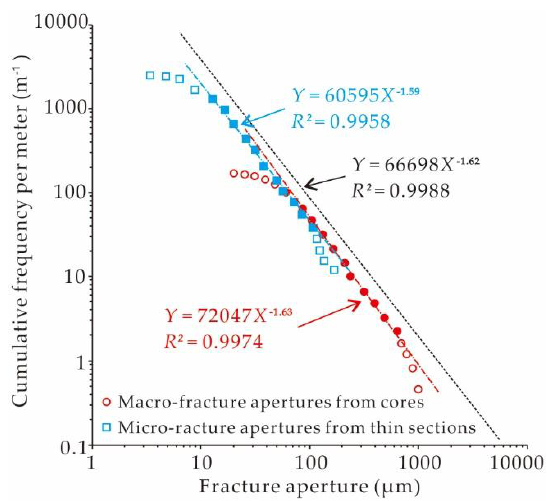
Figure 12. Cumulative plot of micro-fracture apertures (blue squares) and macro-fracture apertures (red circles). The power law distribution of micro-fractures (blue Equation) was obtained by fitting the solid square data, the power law distribution of macro-fractures (red Equation) was obtained by fitting the solid circle data, the power law distribution of all fractures (black Equation) was obtained by fitting the solid square and solid circle data and the best fitting line is slightly offset to the right for clarity of the plot.